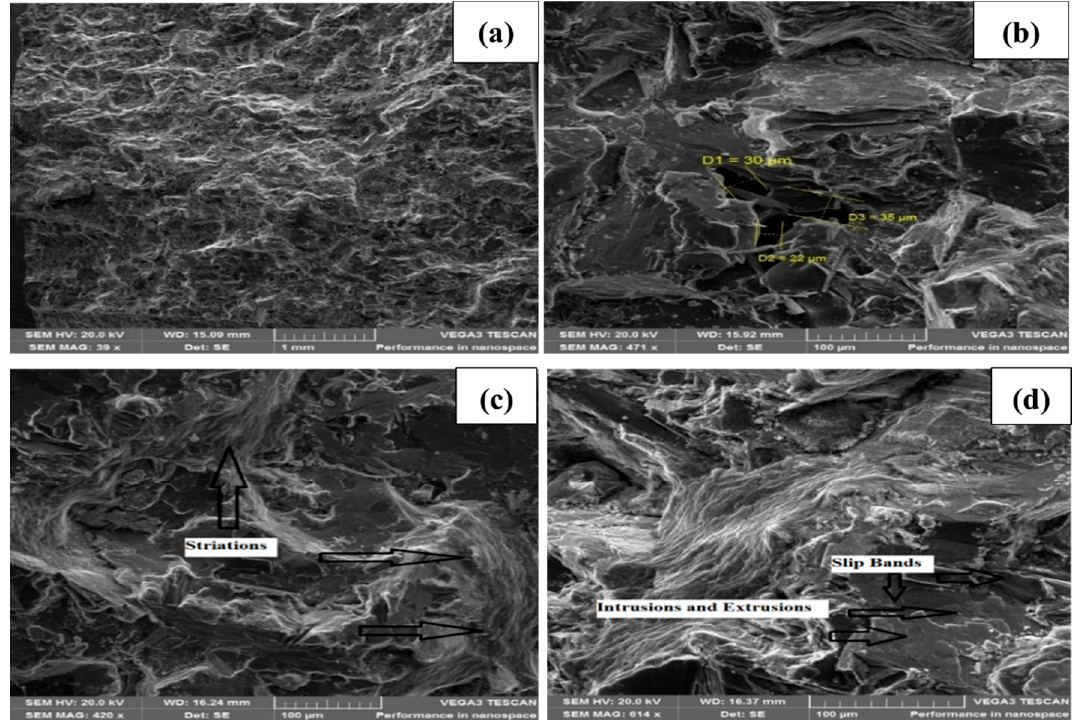
Figure 3. SEM images of fracture surface of base aluminum alloy: ( a ) overall image of the notch area of the specimen from where crack started, ( b ) fracture surface showing the pores dimension, ( c ) striations/river ridges depicting the crack propagation, and ( d ) slip bands on the fracture surface of the specimen.